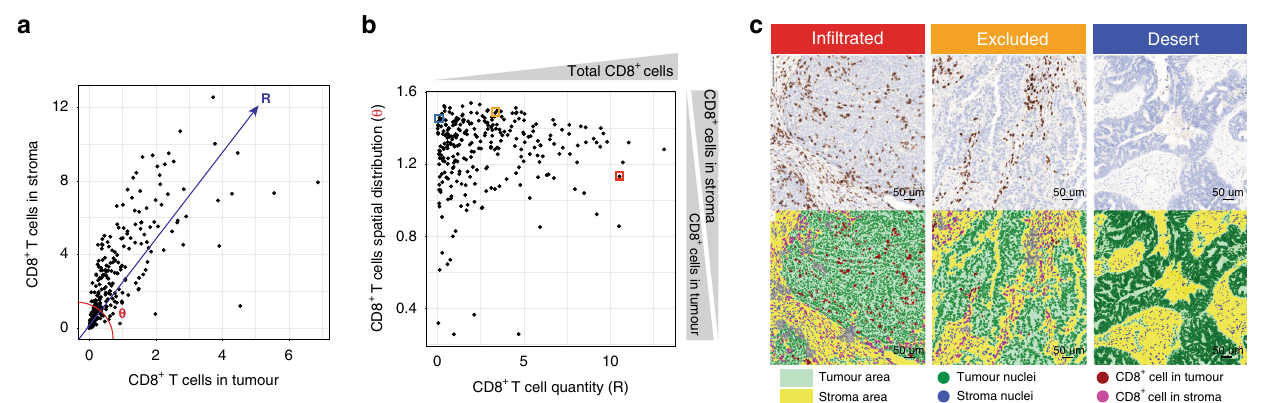
+ T cells in CD8 + T cell quantity (R)CD8 Fig. 1 Spatial quanti fi cation of CD8 + T cells with a digital image analysis algorithm. a Digital pathology quanti fi ed in fi ltration of CD8 + T cells in the stroma and the tumour epithelium. Scores for each compartment are displayed ( n = 155 samples) and b converted into polar coordinates de fi ning two digitally quantitative metrics to pro fi le the immune phenotype of each tumour from the ICON7 training set ( n = 155 samples): (1) x axis, the quantities of CD8 + T cells, de fi ned as R = square root [(CD8 tumour) 2 + (CD8 stroma) 2 ] and (2) y axis, the spatial distribution of CD8 + T cells, de fi ned as θ = atan (CD8 stroma/CD8 tumour). Dots highlighted by a coloured square (blue for desert, orange for excluded and red for in fi ltrated) are the tumour cases displayed in c . c Example images of representative in fi ltrated, excluded and desert tumour-immune phenotypes, were shown to illustrate their distinct CD8 + T-cell distribution in digitally denoted stroma versus tumour areas. Tumour areas (green), stroma areas (yellow), CD8 + cells present in the tumour (dark-red), CD8 + cells present in the stroma (pink). This digital pathology analysis has been performed on 277 tumour samples. Source data are provided as a Source Data fi